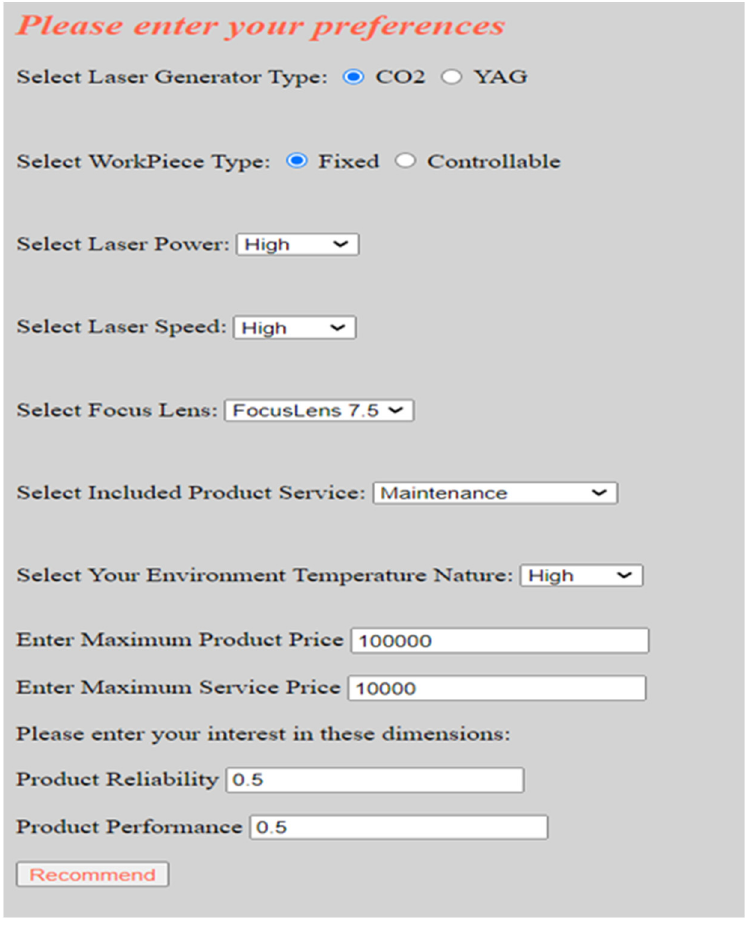
Figure 4. Recommender system knowledge acquisition user interface.